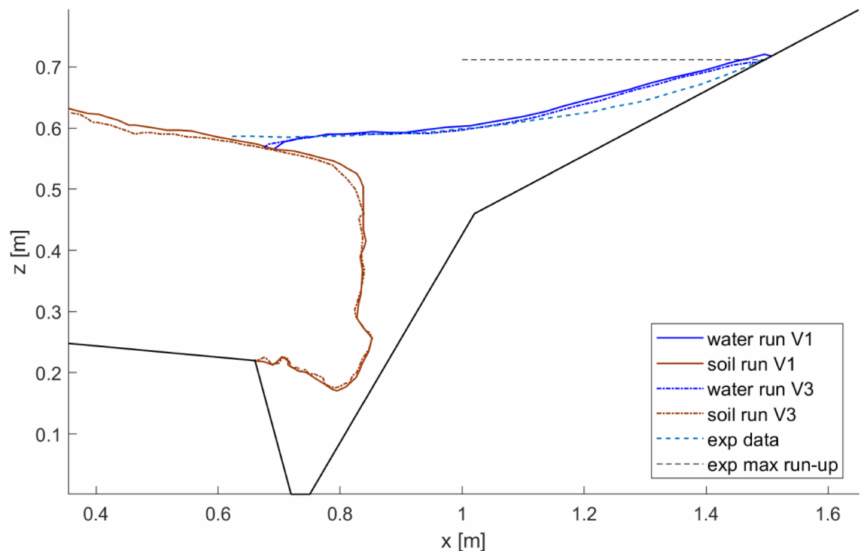
Figure 8. Comparison of maximum simulated run-up at t = 1.35 s for changes in the limiting viscosity. Figure 9 shows the comparison between the profiles from Run V1 (continuous lines) and Run V4 (dash-dot lines) at the same instant of maximum run-up (i.e., t = 1.35 s). Run V4 differs from Run V1 because in the former it has been assumed saturated condition for that portion of landslide below the still water level, as shown in Table 3.